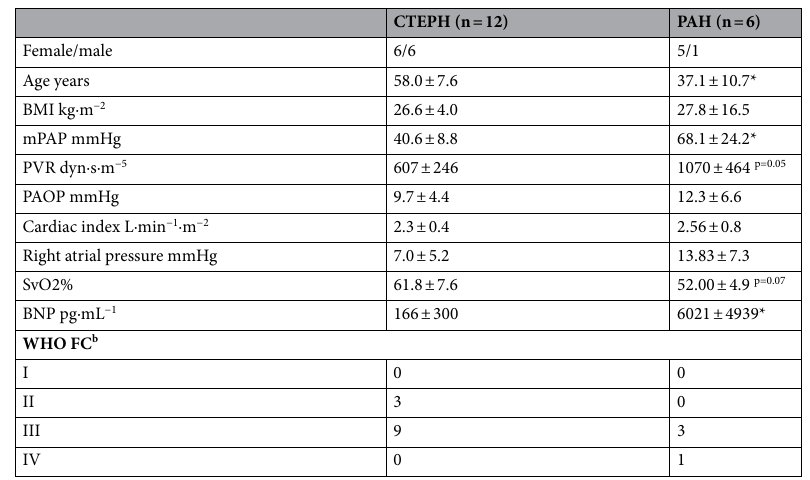
Table 1. Clinical features and hemodynamic parameters. Data are presented as n or mean ± SD. CTEPH chronic thromboembolic pulmonary hypertension, PAH pulmonary arterial hypertension, BMI body